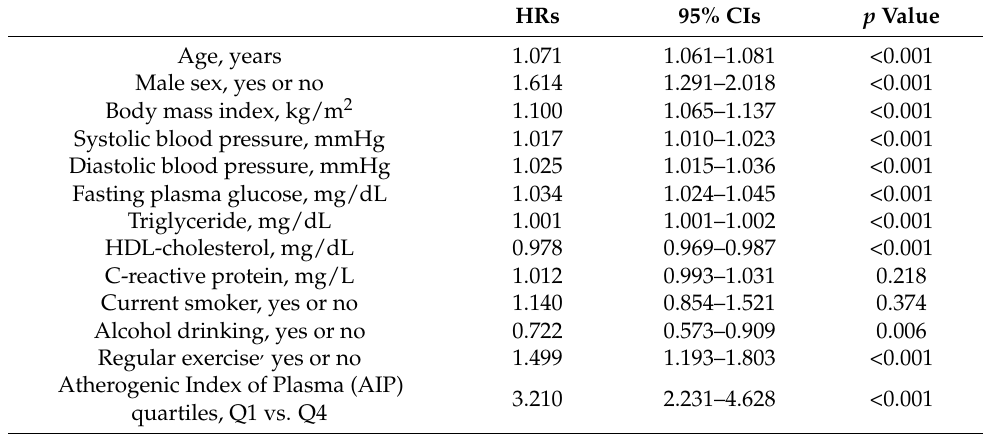
Table 3. Univariate Cox proportional-hazards regression model for incident ischemic heart dis- ease (IHD).